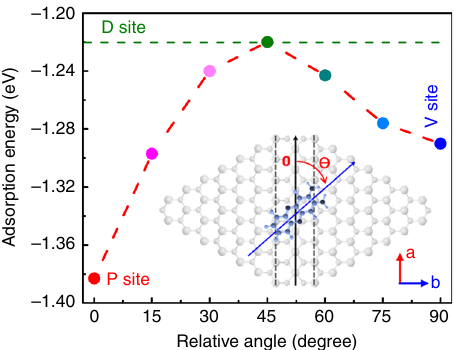
Fig. 6 Angle-dependence adsorption energy of DAP molecule adsorbed on MTB. The inset shows the rotation angle ɵ of DAP relative to MTB. The green dashed line shows the adsorption energy of DAP molecule adsorbed on defect-free MoSe 2 basal plane